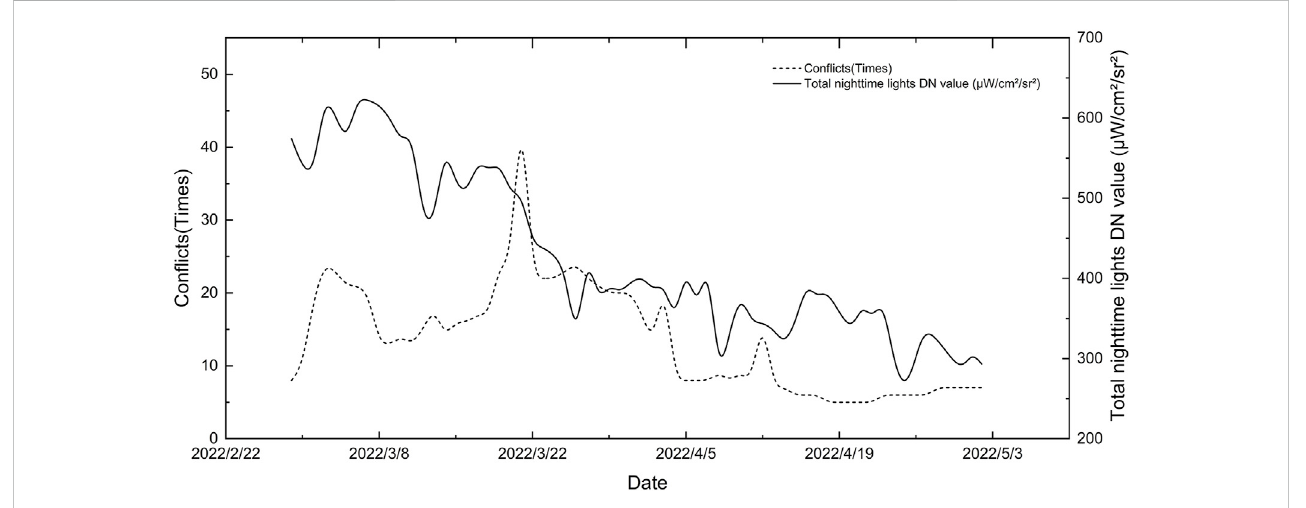
FIGURE 10 Con fl icts and total nighttime light DN values in Ukraine during the war